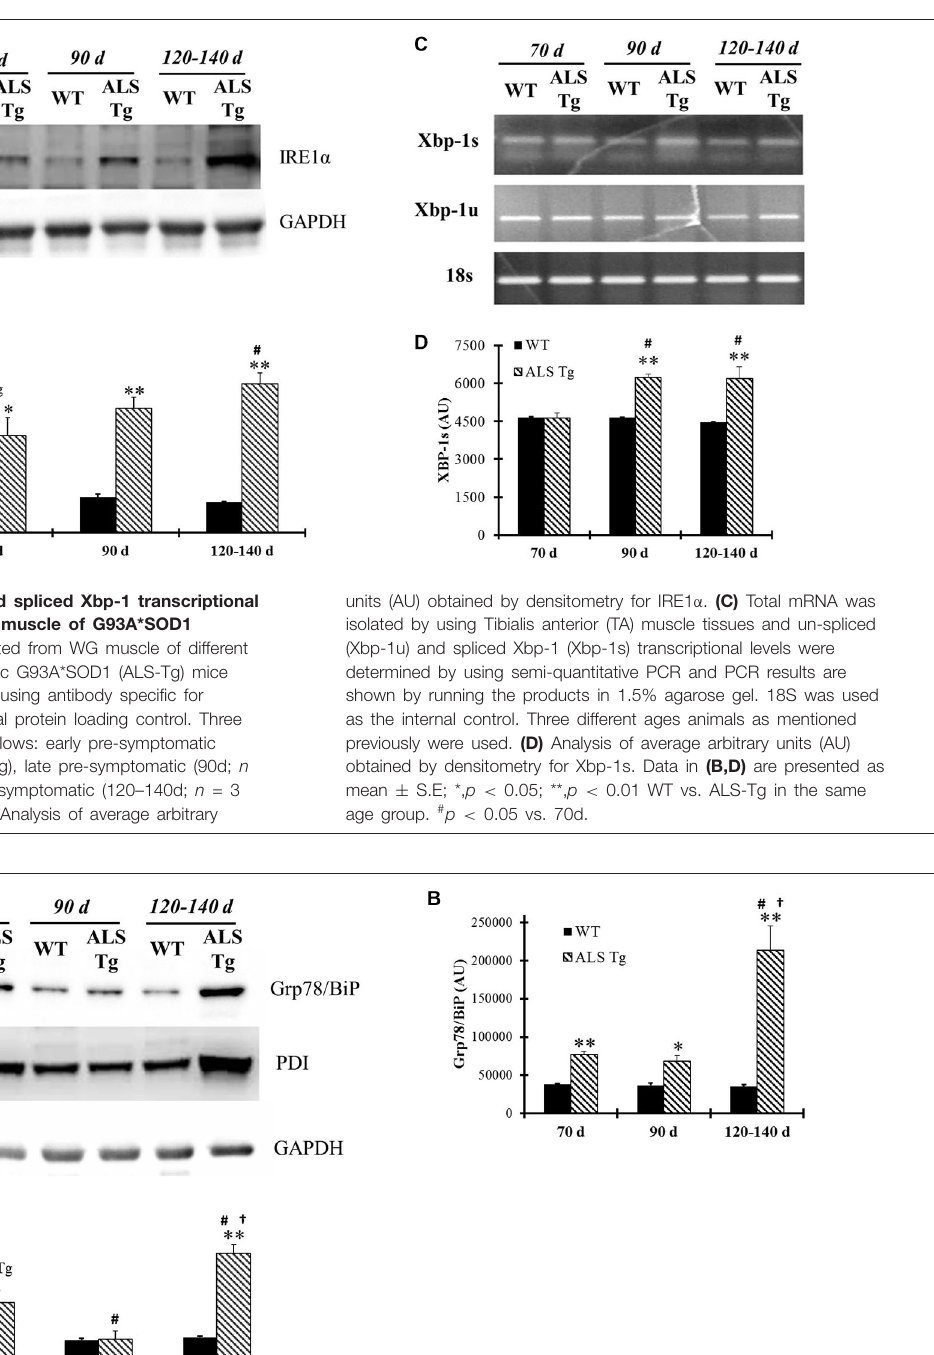
pre-symptomatic (70d; n = 3 each for WT and ALS-Tg), late pre-symptomatic (90d; n = 5 each for WT and ALS-Tg), and symptomatic (120–140d; n = 3 each for WT and ALS-Tg) mice. (B,C) Analysis of average arbitrary units (AU) obtained by densitometry of PDI. Data in B are presented as mean ± S.E; **, p < 0.01 WT vs. ALS-Tg in the same age group. # p < 0.05 vs. 70d and † p < 0.05 vs.